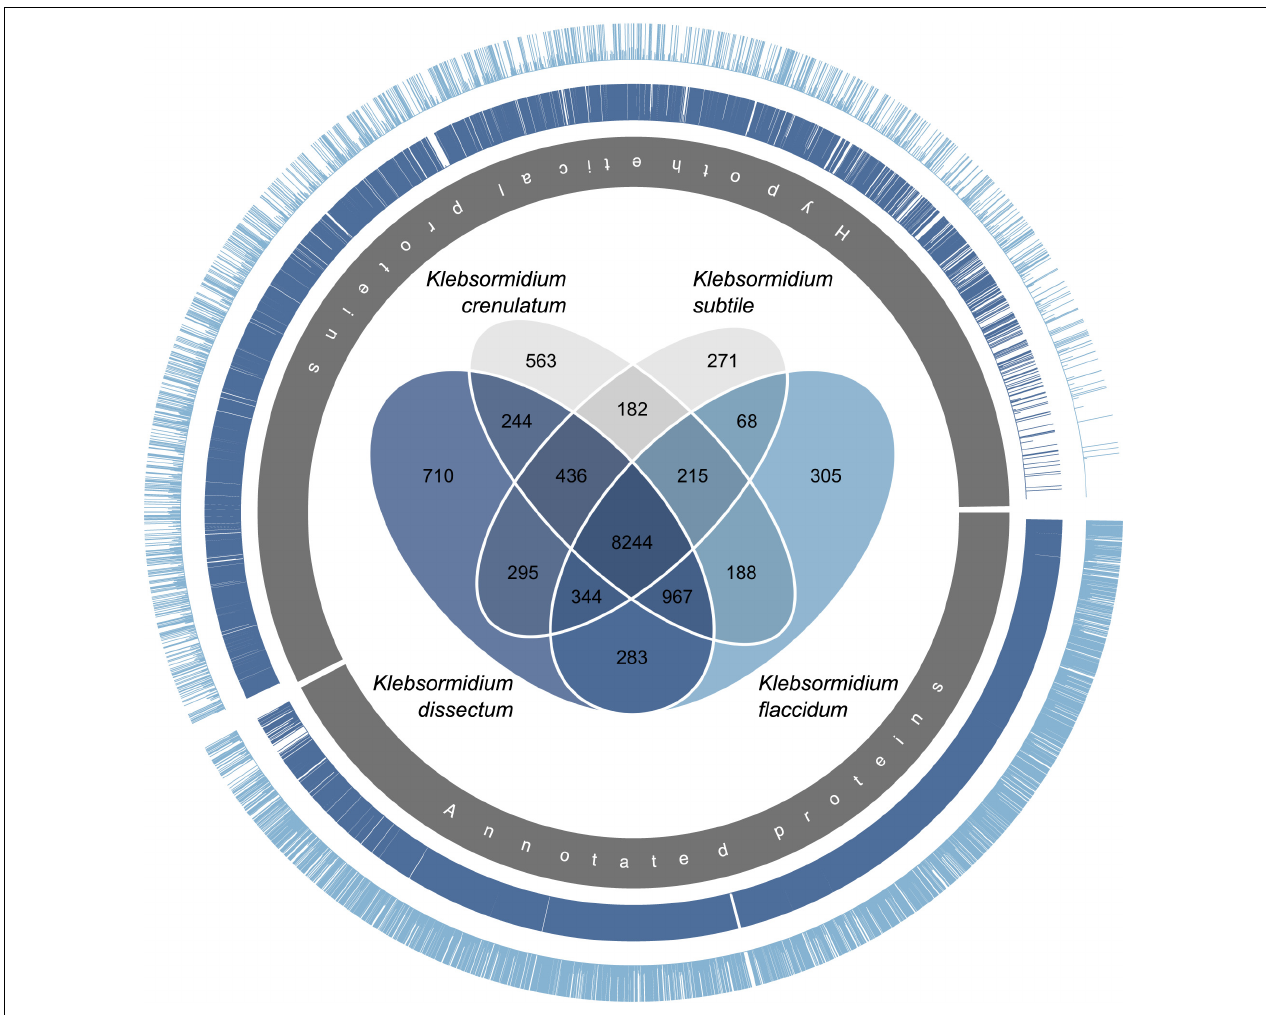
FIGURE 5 | Gene map comparing the genome of K. nitens with the transcriptomes from K. dissectum and K. flaccidum . The inner gray circle indicates the annotated and hypothetical proteins of K. nitens . Each bar in the two outer circles represents a protein of K. nitens being a BLAST top hit when the two transcriptomes were blasted against the K. nitens genome. The bar length indicates the conservation of the protein. The proteins encoded by the K. dissectum transcriptome are generally much more similar to K. nitens proteins than proteins encoded the K. flaccidum transcriptome. The Venn diagram in the center illustrates the similarity of the available Klebsormidium transcriptomes when the transcriptomes were blasted against the K. nitens genome using the BLASTN algorithm and an e -value cut-off of E –10.